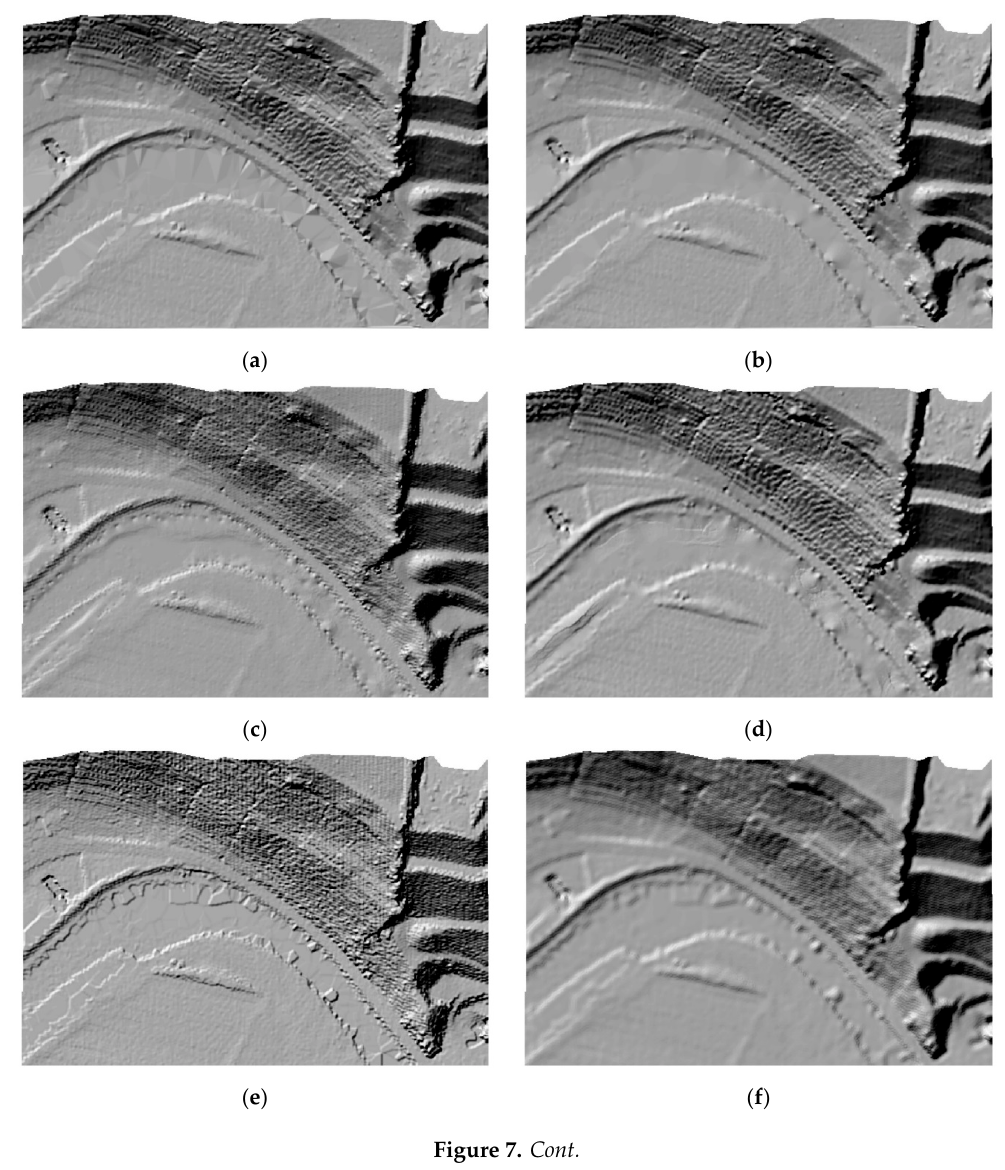
on the 10 public datasets.